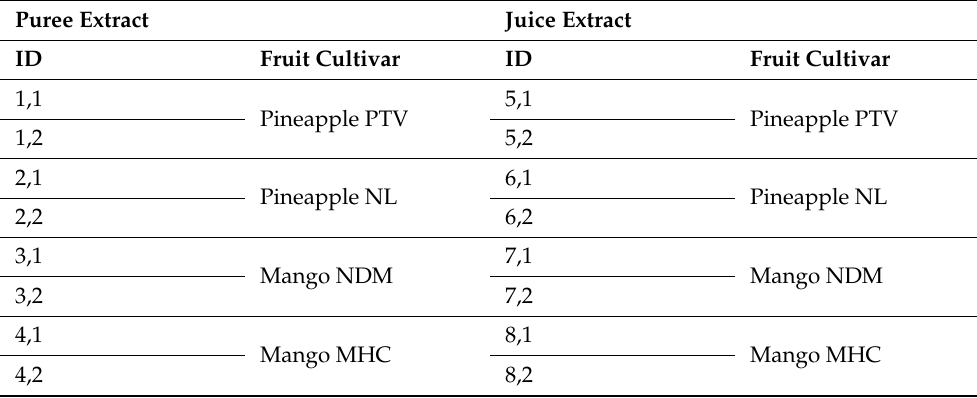
Figure 1. Saccharide analysis: HPTLC-Vis chromatogram of fructose (Fru), glucose (Glc) and sucrose (Suc) present in fruit product extracts (IDs 1 – 8, Table 2, 0.4 g/mL in methanol, 0.5 µL/area) on HPTLC plates silica gel 60 F 254 with acetonitrile – water 4:1, V/V, plus 8 mg diphenylboric acid-2- aminoethylester (Table S1 from Supplementary Materials, mobile phase 6) derivatized with diphenylamine aniline o- phosphoric acid reagent and documented at white light illumination. Table 2. Produced fruit products (IDs 1–8) extracted either with methanol (x,1) or ethyl acetate